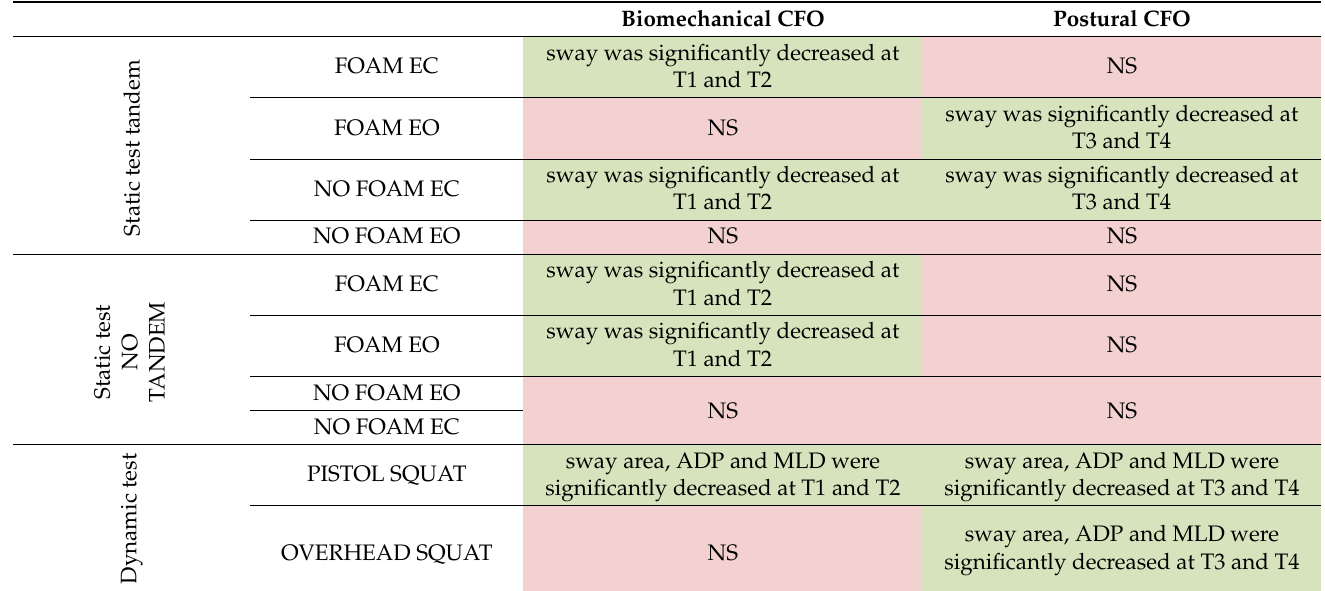
Table 4. Correlations between postural parameters and effects of orthoses (biomechanics CFO and postural CFO) on different tests (static and dynamic). NS = non-significant correlations. DEV.STD. = standard deviation.